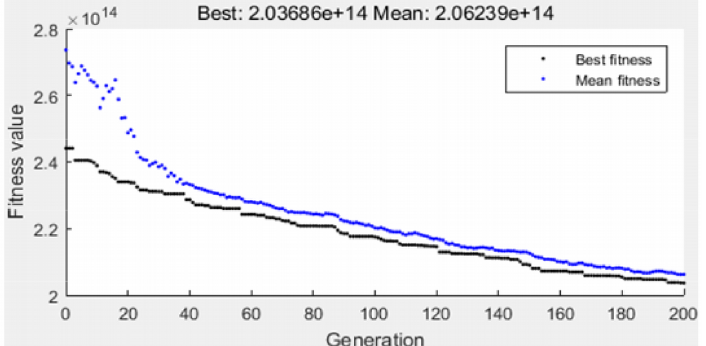
Figure 6. Convergence curve of genetic algorithm in southern, r = 1,  = 15